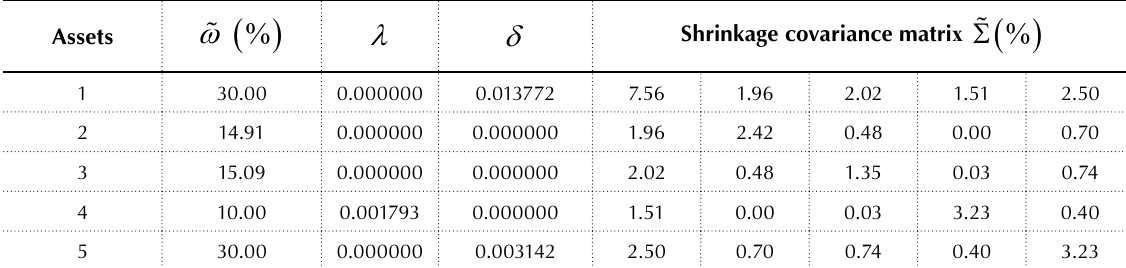
Table 3. Results for the constrained EIT problem, with weights constraints